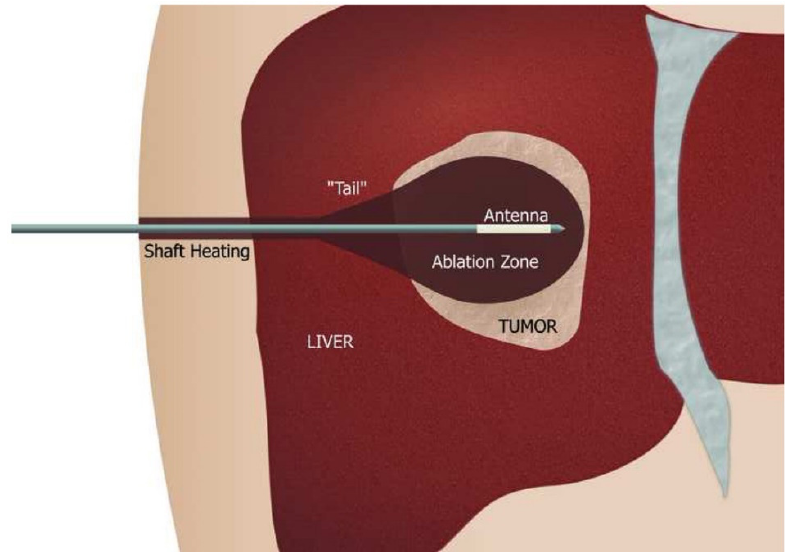
Figure 5. Microwave ablation schematic. The microwave antenna is made up of an applicator shaft that has temperature monitoring to combat shaft heating. Shaft heating occurs due to the reflection of the microwave and a cooling system is installed along the shaft to prevent burning. The antenna is most often needle-shaped but can have a variety of designs including monopole, dipole, and slotted antennas. The antenna design determines the tissue heating pattern and therefore impacts the ablation zone size and shape [39,40].